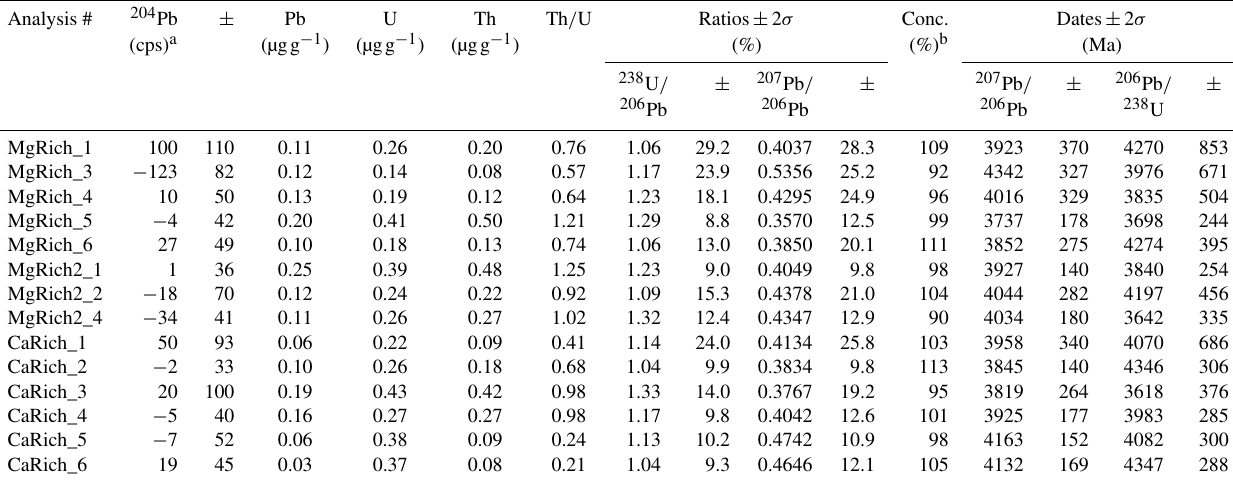
Table 1. LA-ICP-MS results for ALH 84001 carbonates.